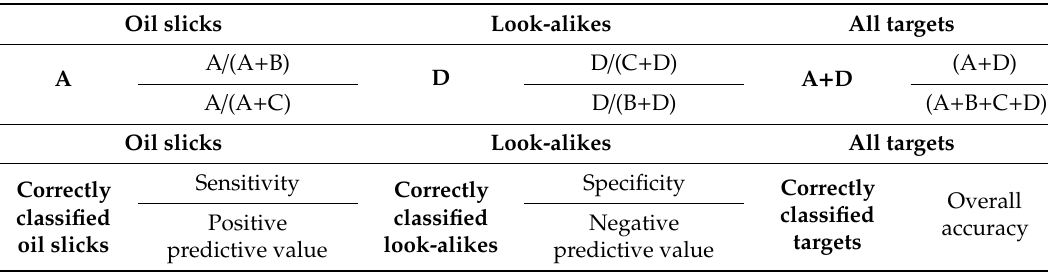
Table 4. “Condensed” form of the confusion matrix shown in Table 1 used to access the classification accuracy of our Linear Discriminant Analyses (LDAs). See also Tables 2 and